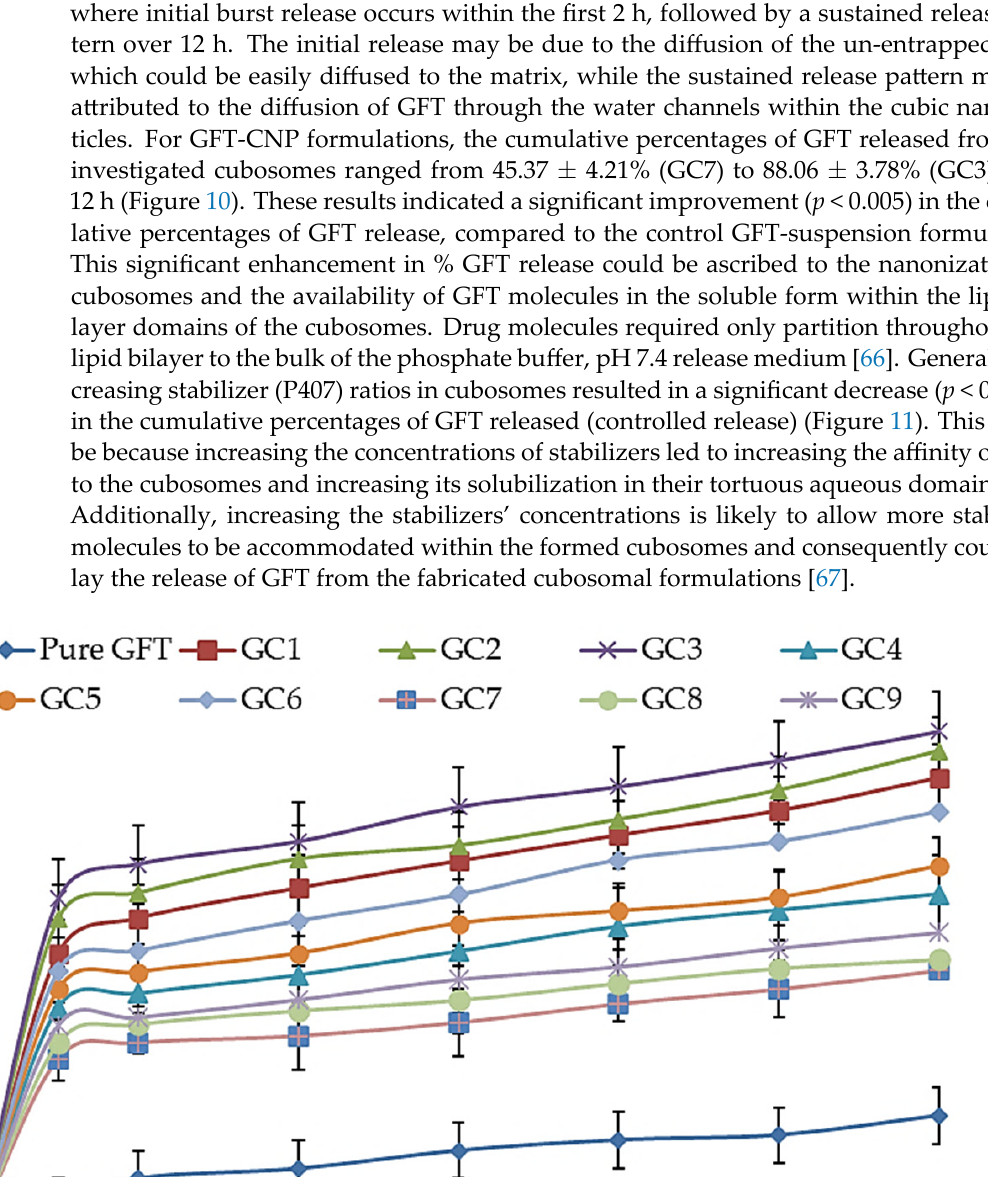
Figure 11. Main effects ( A ) and response surface plots ( B ) of GMO/P407 and P407% on cumulative percentage GFT released. The obtained results showed that the larger the particle size of cubosomes, the smaller the cubosomal surface area exposed to the release media, which results in a sus- tained drug release [68]. In particular, GC3, prepared with lower P407 content, showed a prompt drug release and significantly ( p < 0.05) higher value of cumulative percent re- leased after 12 h as compared to pure GFT suspension and the other cubosomal formula- tions. This may be attributed to the extremely small particle size of GC3 (98 ± 20 nm), which provides a larger effective surface area for drug release and a short diffusion dis- tance for the rapid release of the entrapped drug from cubosomes. A rapid release of lip- ophilic drugs from cubosomes has been previously reported [69]. The best-fit model for GFT release from the fabricated nanosized cubosomes was Korsemeyer-Peppas, with the highest R 2 (Table 3). The diffusion exponent was between 0.5 and 1, and the GFT release from GFT-CNP dispersions underwent a non-fickian release mechanism, revealing that the release was controlled by the GFT diffusion rate and the relaxation rate of the polymer (P407).